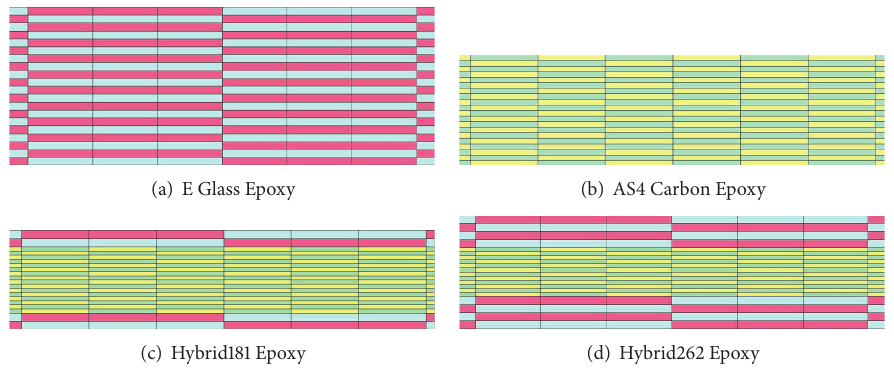
Figure 4: Finite element meshing for various epoxy laminates.